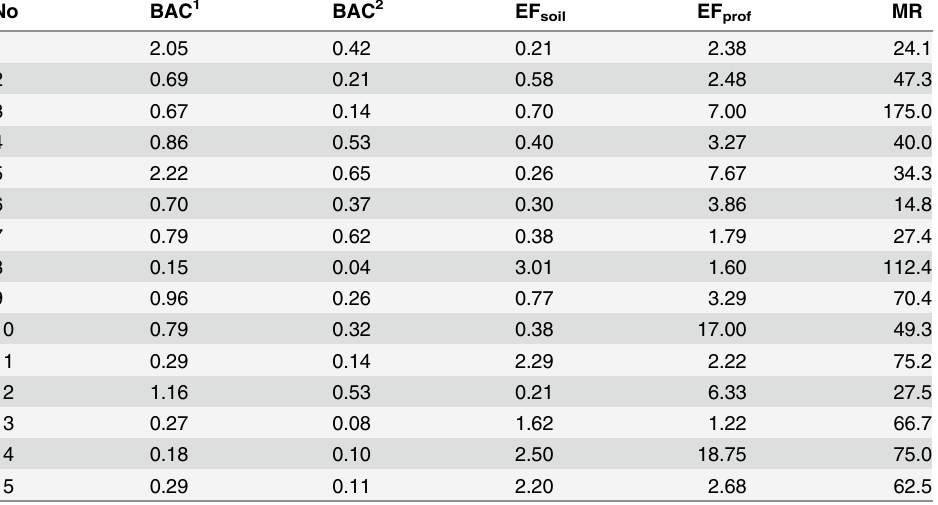
Table 2. Values of biological